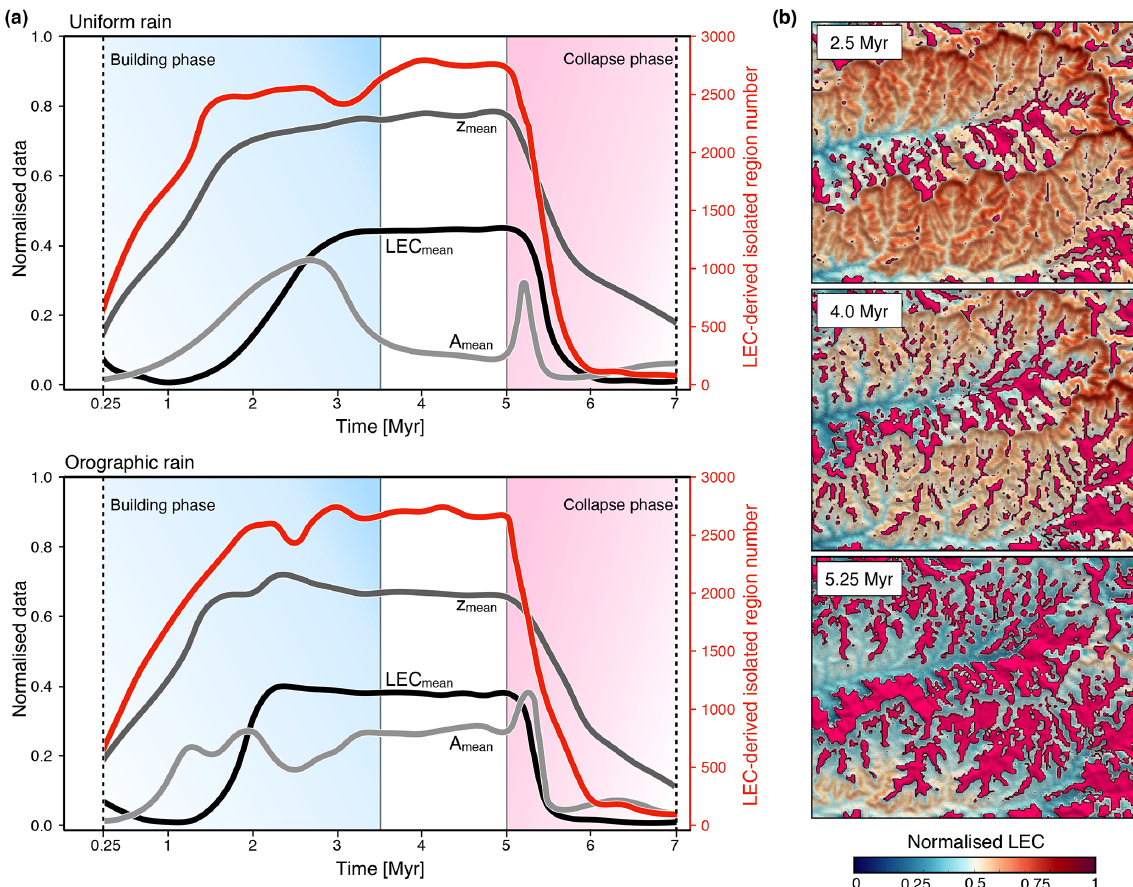
Figure 10. Temporal evolution of the isolating effect of mountain geomorphology derived from LEC computation. The method consists of mapping and integrating over space and time regions of lower connectivities (normalised LEC < 20%) surrounded by higher ones. (a) Analysis of isolated regions for the uniform and orographic precipitation simulations. Each panel presents the mean elevation ( z mean – dark grey), LEC (LEC mean – black), and area ( A mean – light grey) for the isolated regions as well as the total number of extracted regions (red line) through time. (b) Normalised connectivity maps showing for the orographic model the distribution of isolated regions (magenta areas) at three time intervals. The considered maps correspond to the highlighted region C defined in Fig. 4d. Both simulations exhibit a similar trend with an increase in the number of isolated regions during the building phase (shaded blue area) followed by a period of stabilisation and a rapid decrease during the relaxation phase (shaded red area). We note a sharp increase in mean area at 5Myr attributed to the rapid adjustment of upper valley slopes following the cessation of